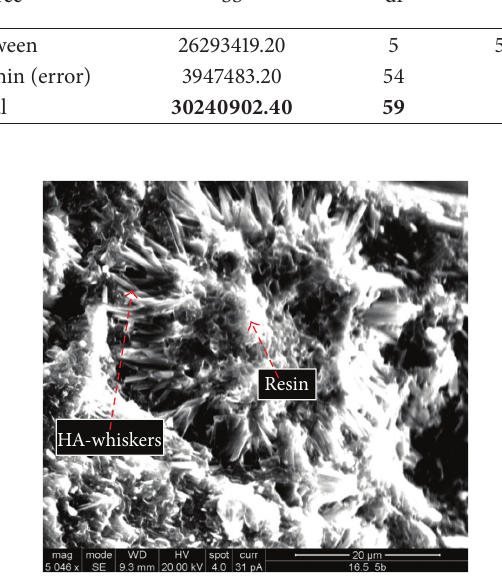
Figure 5: SEM micrograph at high magnification of the composite resin reinforced with hydroxyapatite whiskers.